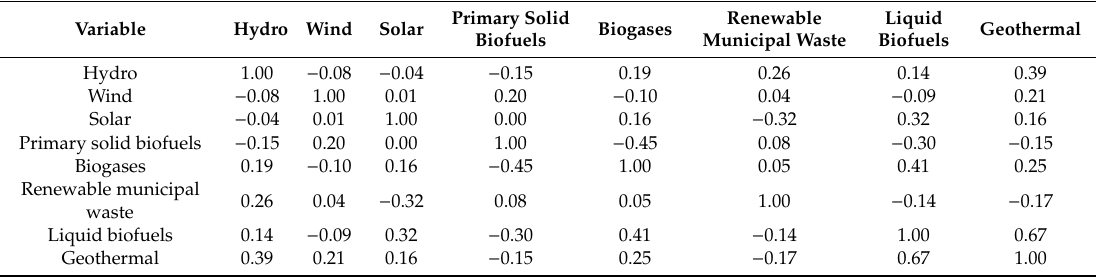
Table 10. Correlation coe ffi cients for energy production from renewable energy sources in the EU countries per capita in 2017 (own